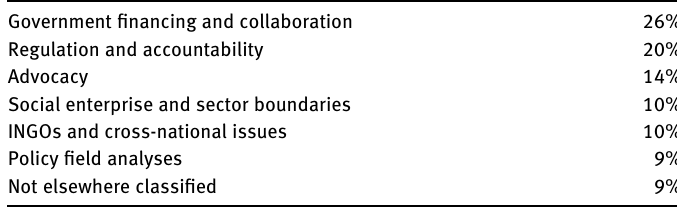
Table  : Distribution of NPF articles by thematic focus,  – 